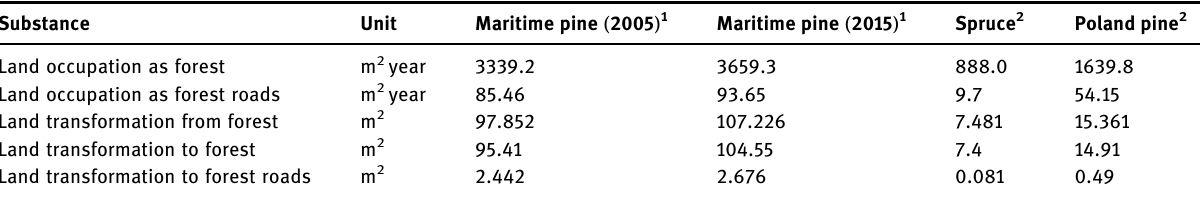
Table 5: Comparing inventory items of di ff erent species ( FU = 1 m 3 of wood, standing, in forest )